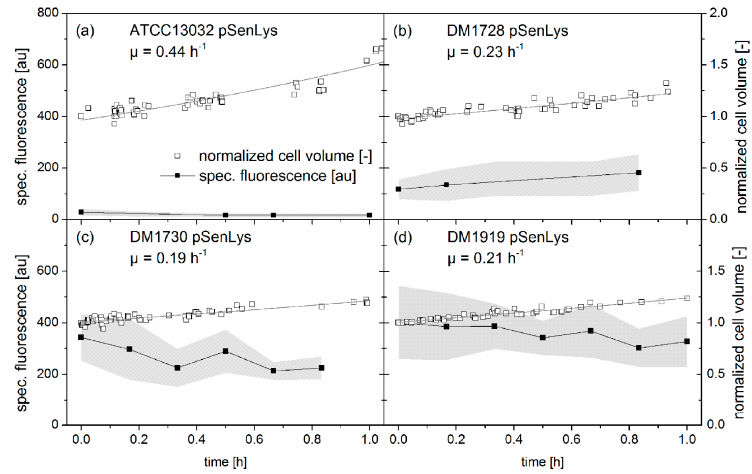
Figure 8. Normalized cell volumes and specific fluorescence of ( a ) C. glutamicum ATCC13032, ( b ) DM1728, ( c ) DM1730 and ( d ) DM1919. All strains carried sensor plasmid pSenLys for L -lysine-dependent eYFP production. The cell volumes were normalized to the initial cell volume of